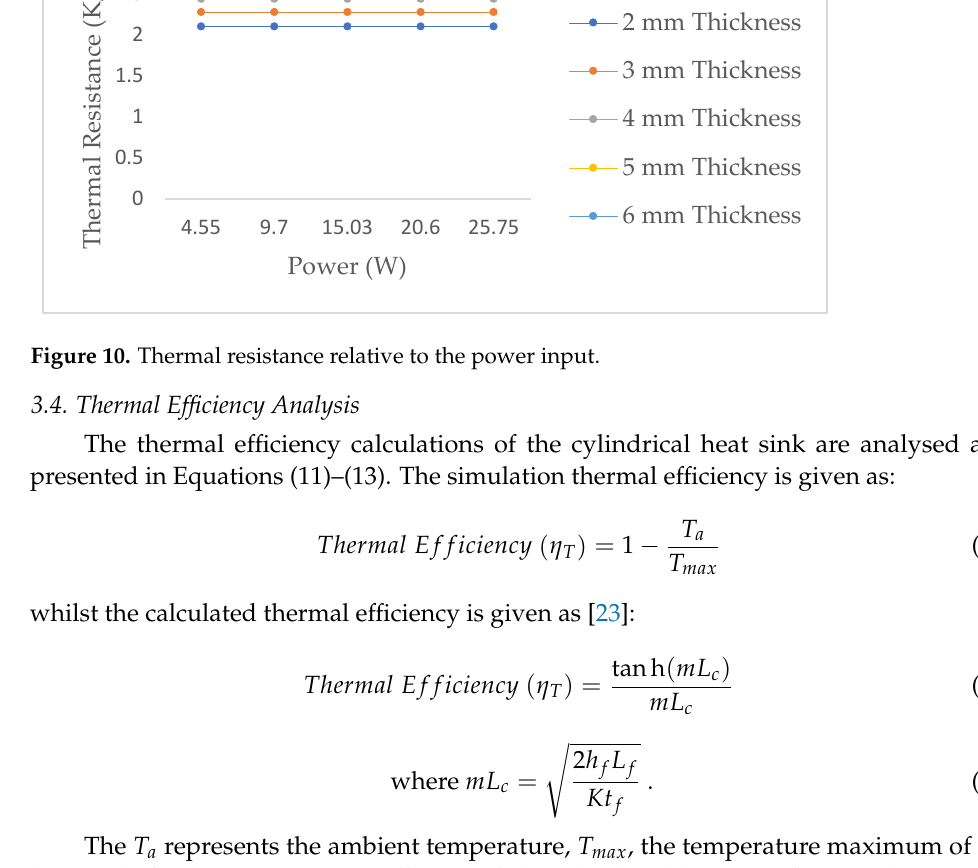
Figure 9. Thermal Resistance of Heat Sink.